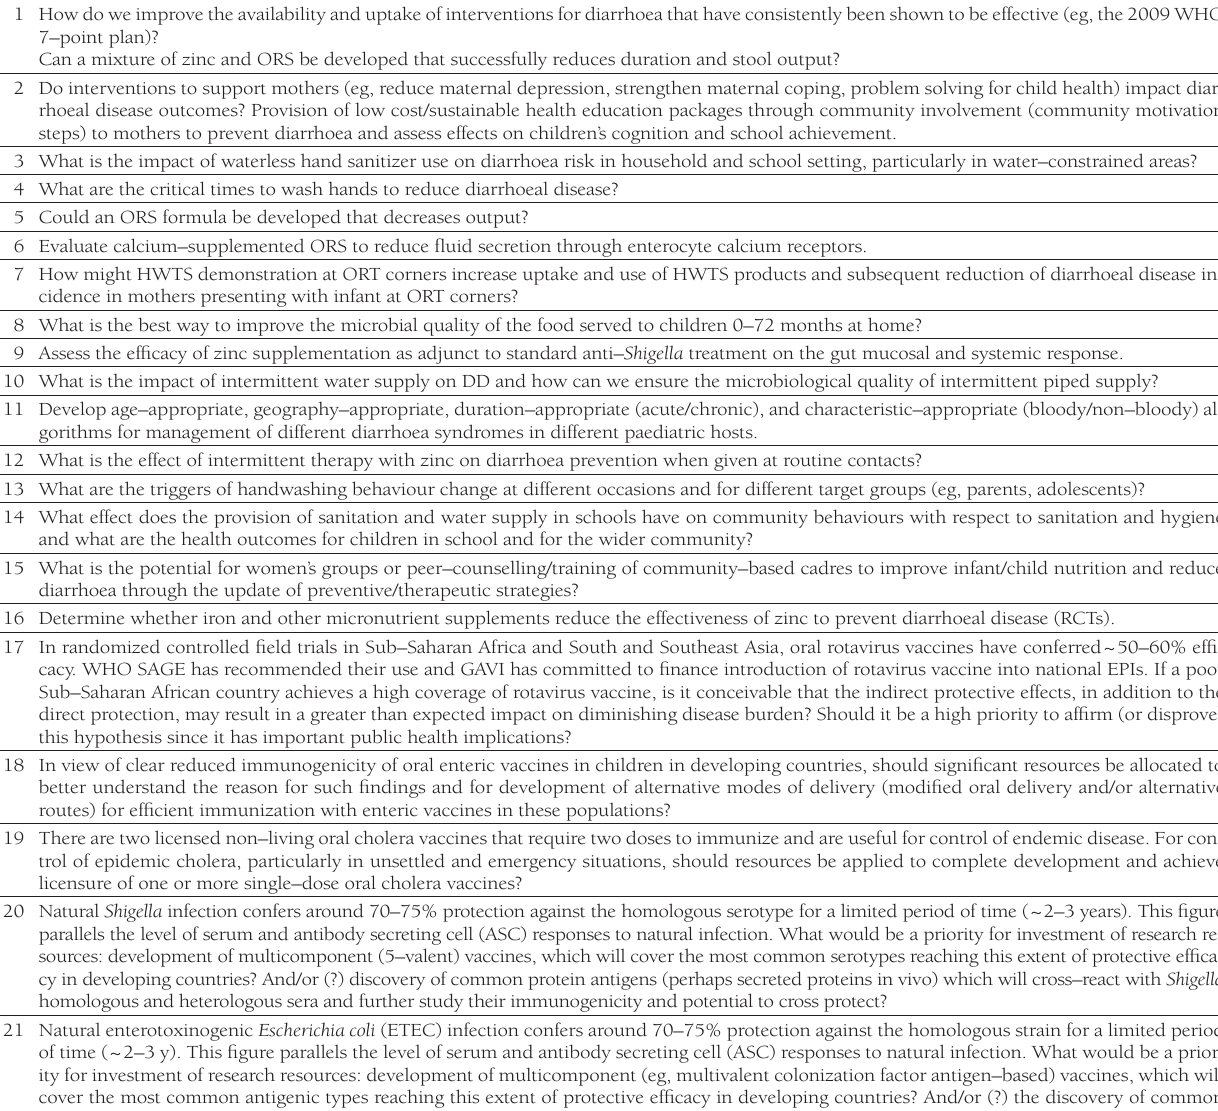
Table 3. Development related questions identified by the CHNRI